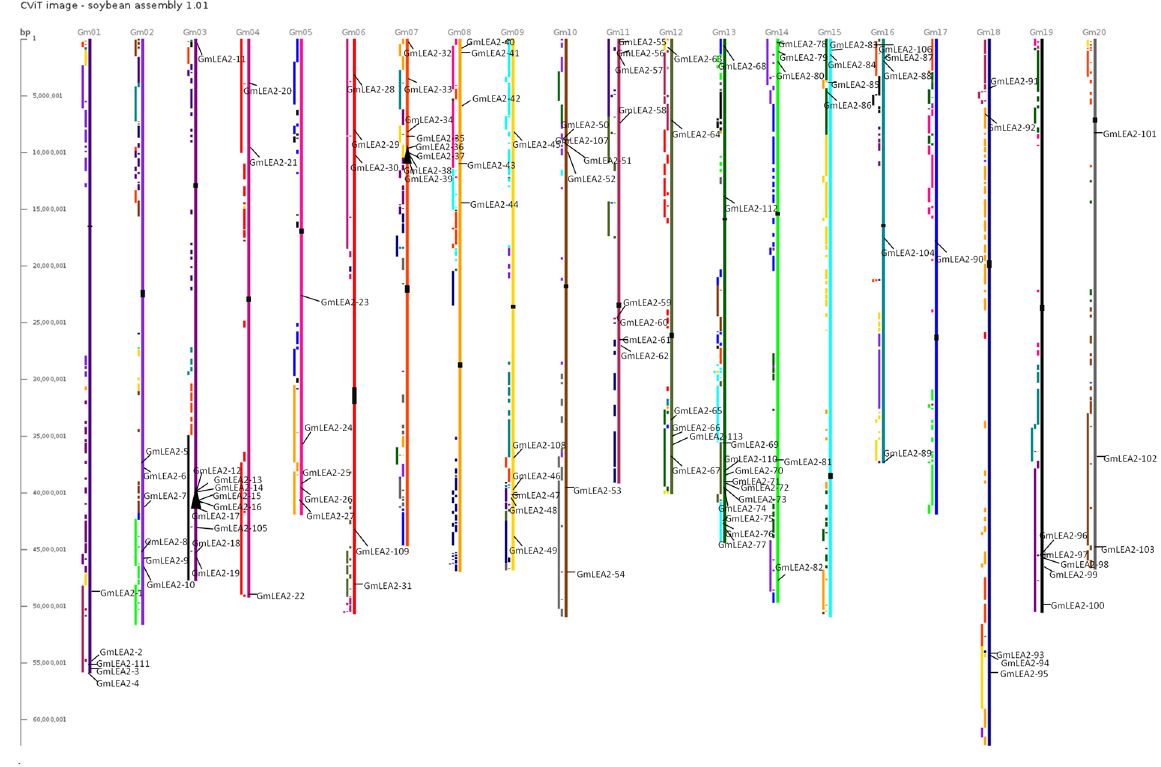
Figure 2. Chromosomal location and region duplication of soybean LEA2 genes. The black triangle Icon were marked as tandem duplication of syntaxin proteins on chromosome 3 and 7. The scale on the left represents the length of the